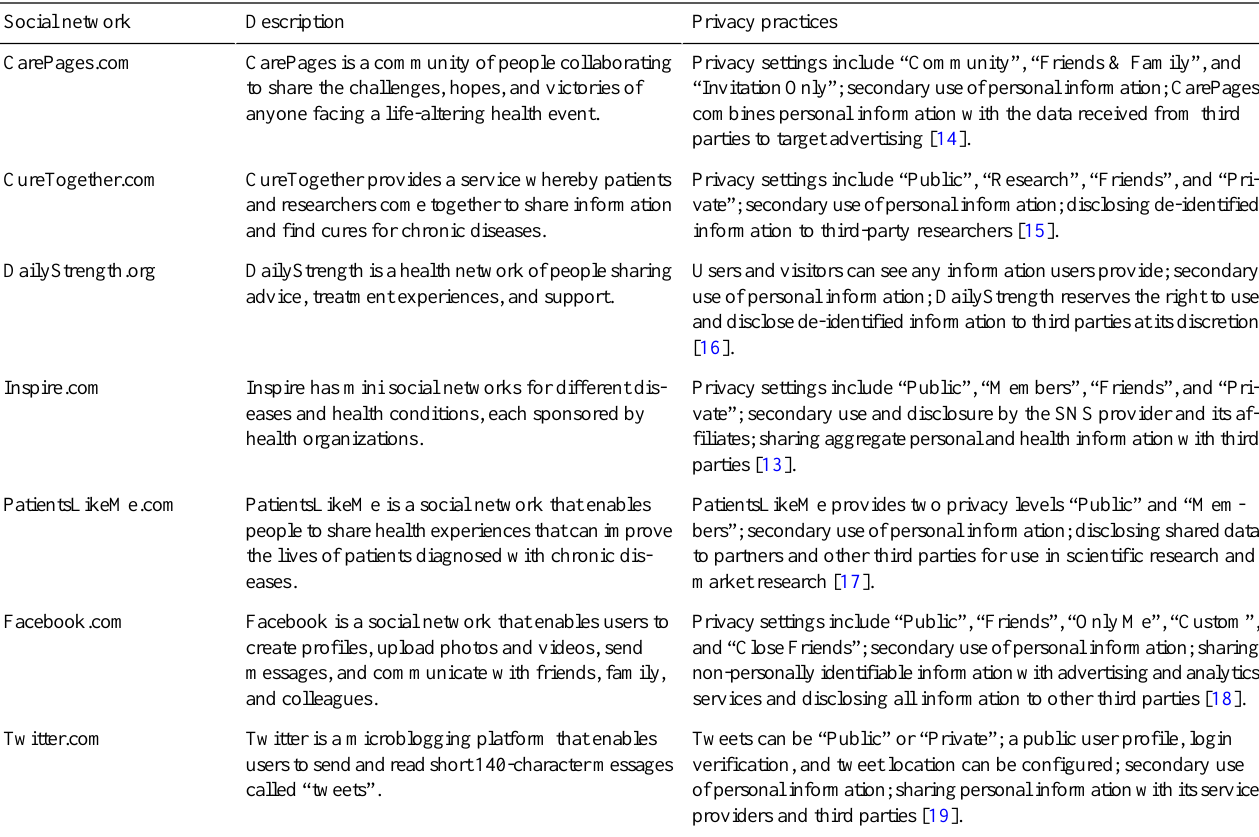
Table 1. Examples of health-related social networks and general social